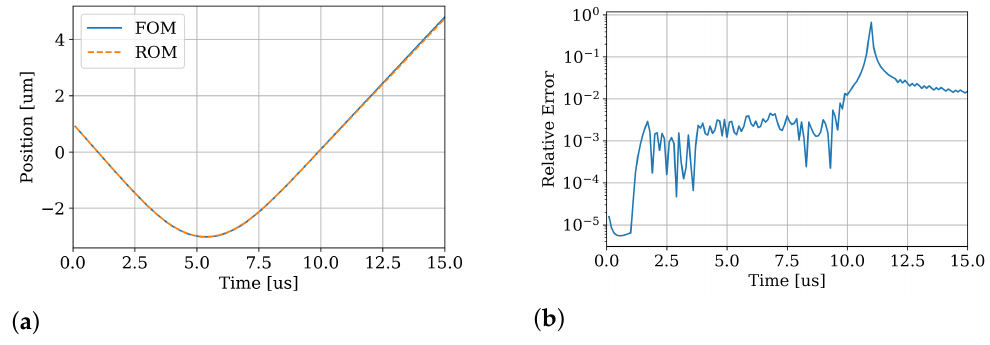
Figure 9. The sphere’s vertical position during impact measured from its lowest point. ( a ) The solutions of the reference FE model and the ROM. ( b ) The ROM’s relative error increases in time as deviations accumulate. The sphere leaves contact after 11µs, causing a high error at this point in time. Note that, due to limitations of commercial software, different methods are used for time integration.